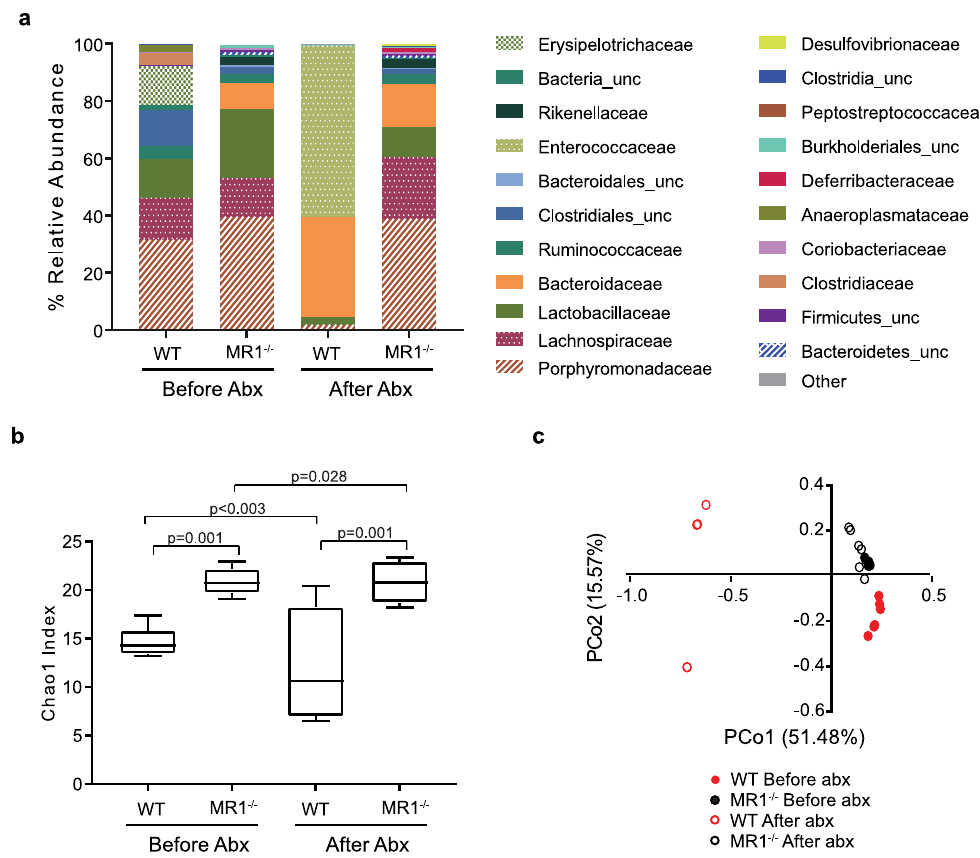
Fig 3. The gut microbiota composition of MR1 -/- mice contrasts that of WT mice before and after cefoperazone treatment. (A) 16S rRNA gene sequencing was performed on fecal samples from mice before and after antibiotic treatment. Data shown are mean % relative abundance at the family level. “_unc” denotes sequences unclassified at the family level; the lowest level identified is listed. Only taxa with � 1% are presented. Data presented are mean ± SD; before antibiotics: WT n = 6, MR1-/- n = 6; after antibiotics: WT n = 5, MR1-/-n = 7. (B) Chao1 richness estimations of alpha diversity among all samples analyzed in panel A before and after antibiotic treatment. (C) Principle coordinate analysis (PCoA) of ThetaYC distances. Before antibiotics: WT n = 6, MR1-/- n = 6. After antibiotics: WT n = 5, MR1-/-n = 7.